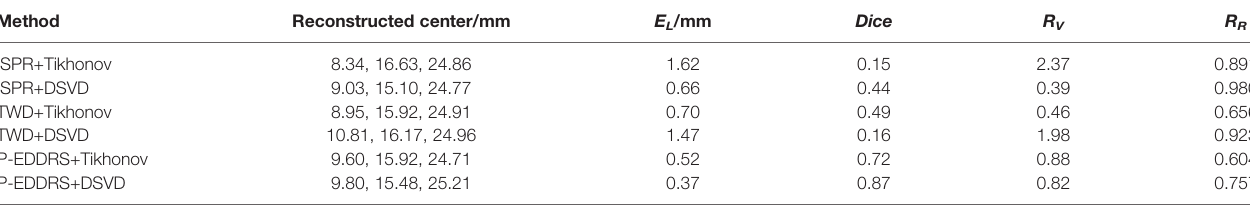
TABLE 3 | Quantitative evaluation results of P-EDDRS framework ef fi ciency veri fi cation in CLT.